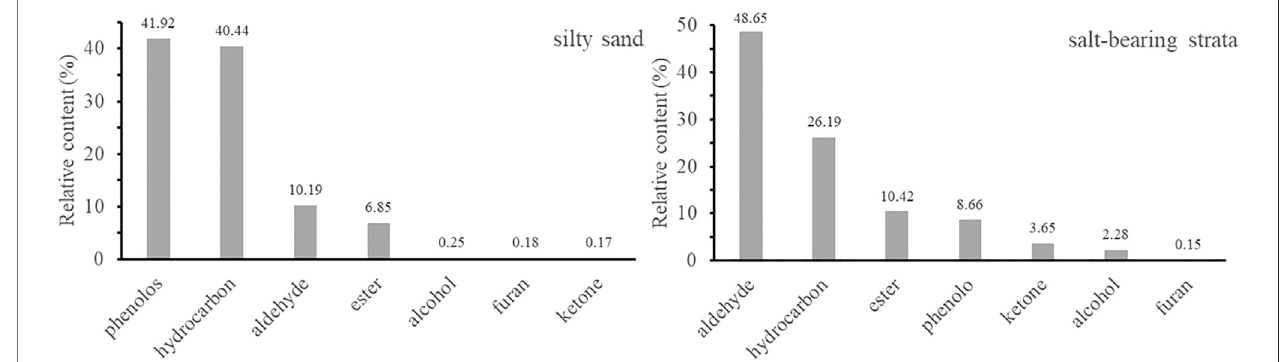
FIGURE 5 | Organic matter content in different lithologic strata.